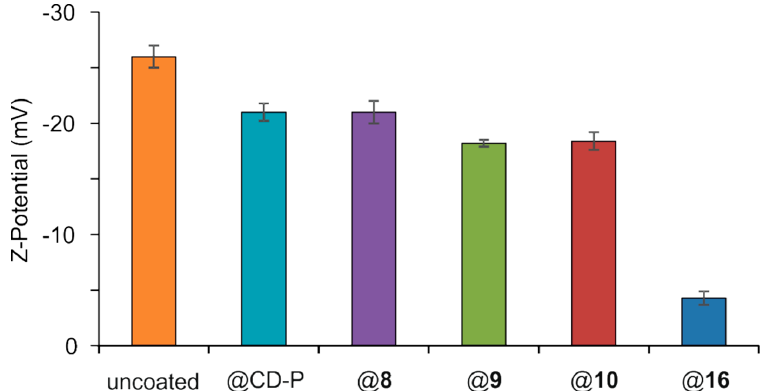
Figure 3. Zeta potential of nanoMOFs coated or not with PCDs in 10 mM PBS at pH 7.4.